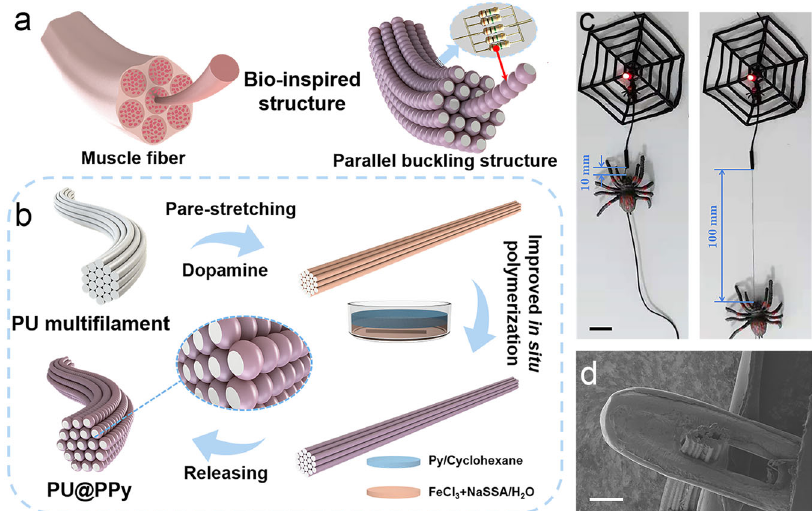
Fig. 1 The parallel PU mono fi lament with PPy buckling on surface, showing an ultra-high strain insensitive conductivity. a Prototypical model of the PU@PPy multi fi lament. b Schematic illustration of preparation of the conductive PU@PPy multi fi lament. c Optical images @PPy multi fi lament. Scale bar is 20 mm. d SEM image showing the PU 420D showing LED response to different elongations of the PU 420D 200 % multi fi lament passing through a #1 needle. Scale bar is 300 μ